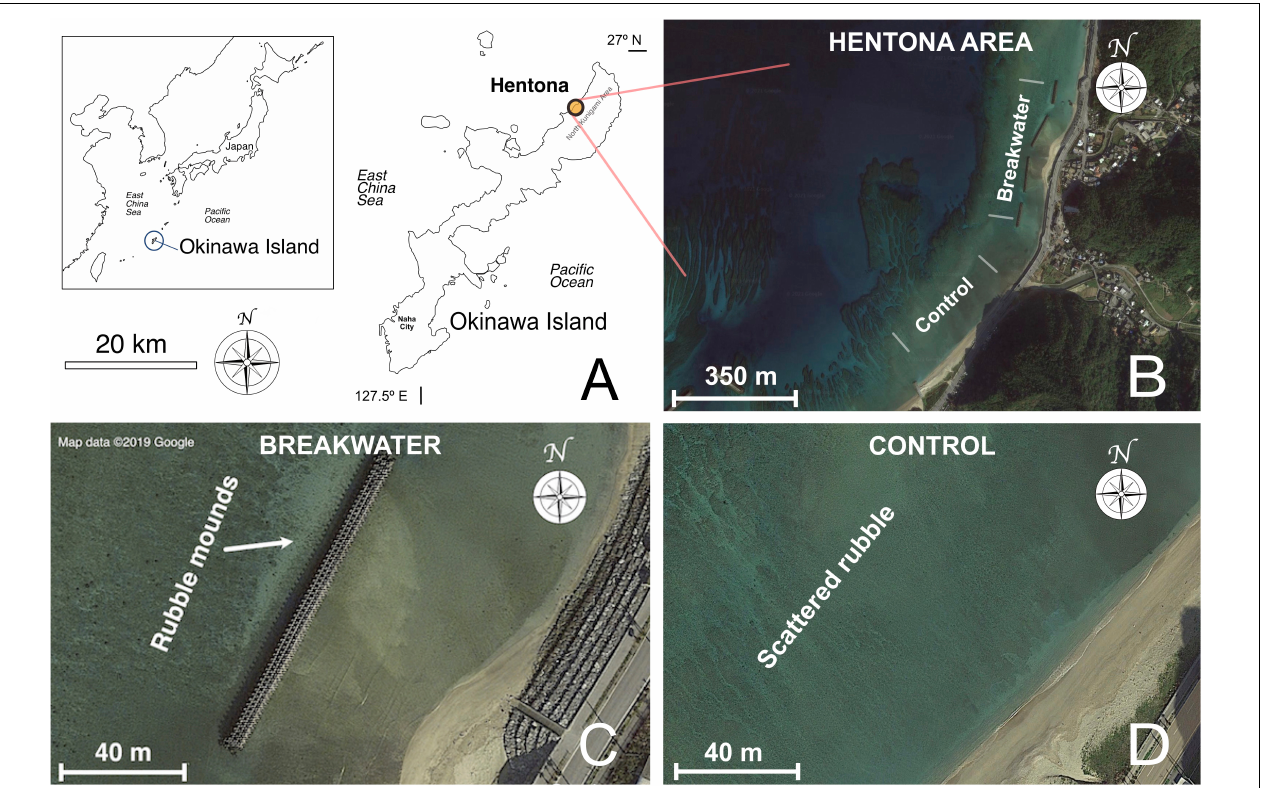
FIGURE 1 | (A) Okinawa Island, southern Japan, north-west Pacific Ocean. The yellow circle highlights the Hentona area (North Kunigami), the geographical location where this study was conducted. (B) Satellite view of the Hentona area. (C) Detail of a portion of the Hentona breakwater. The arrow highlights the rubble mound formation at the seaward side of the barrier. (D) Detail of the Hentona control site. Rubble is scattered, no clear mound formation